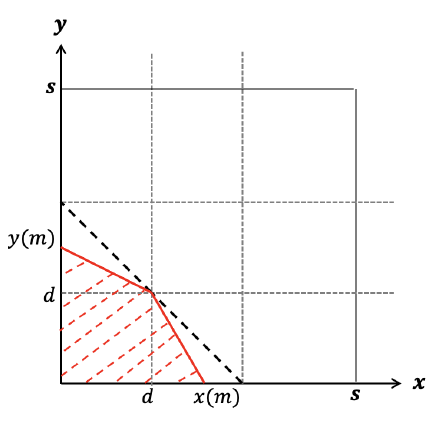
Figure A6. Default region for k = d